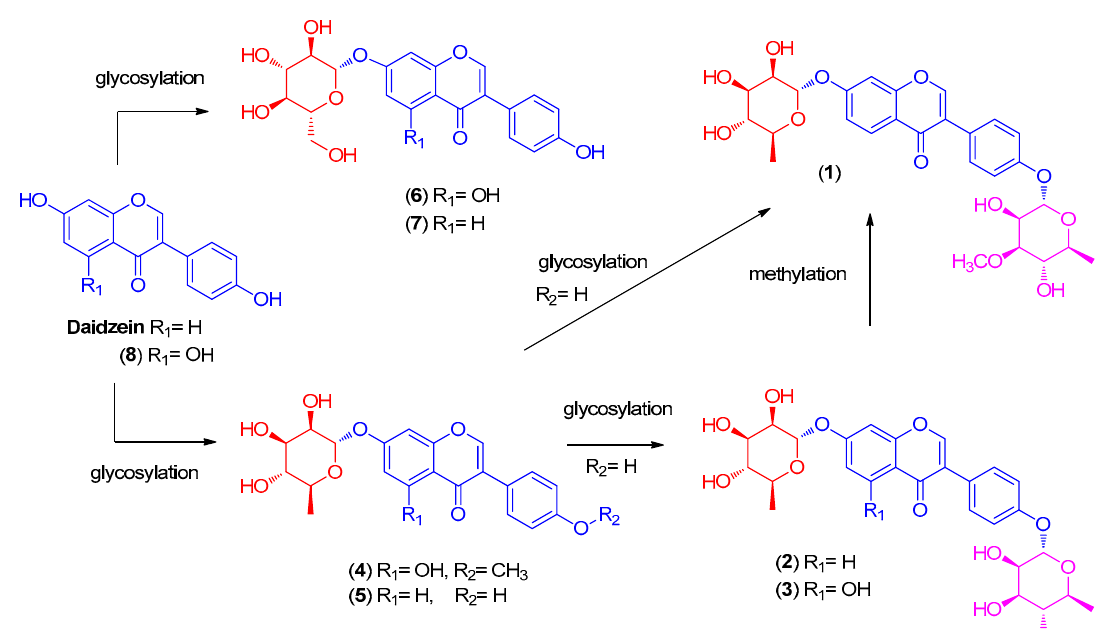
Figure 3. Putative sequence of transformations of compounds 1 – 8 .